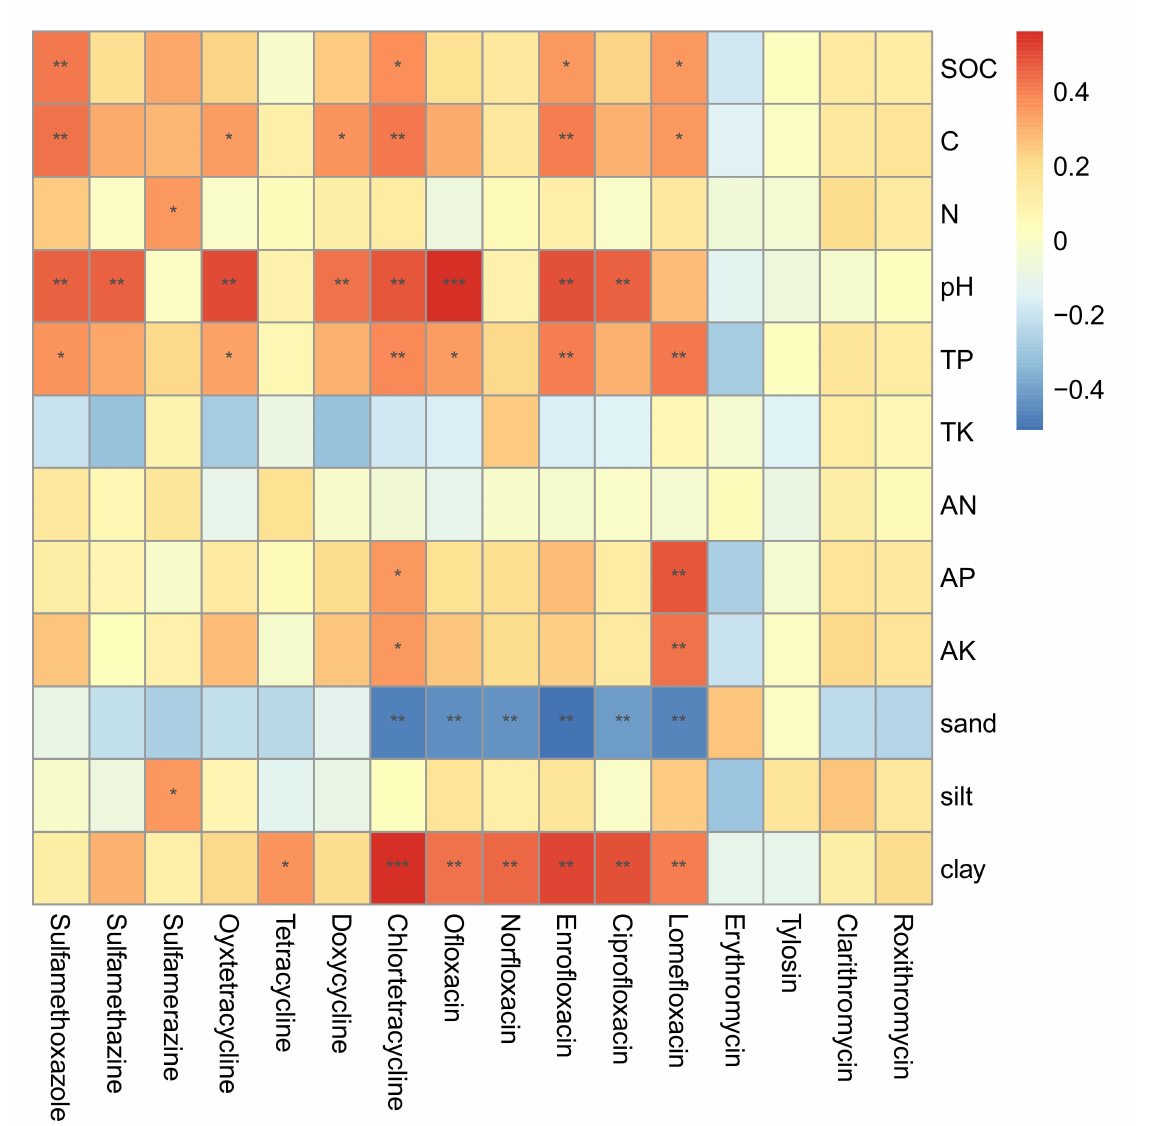
Figure 3. Correlations between soil properties and antibiotic residues. *: p < 0.05, **: p < 0.01, and ***: p <